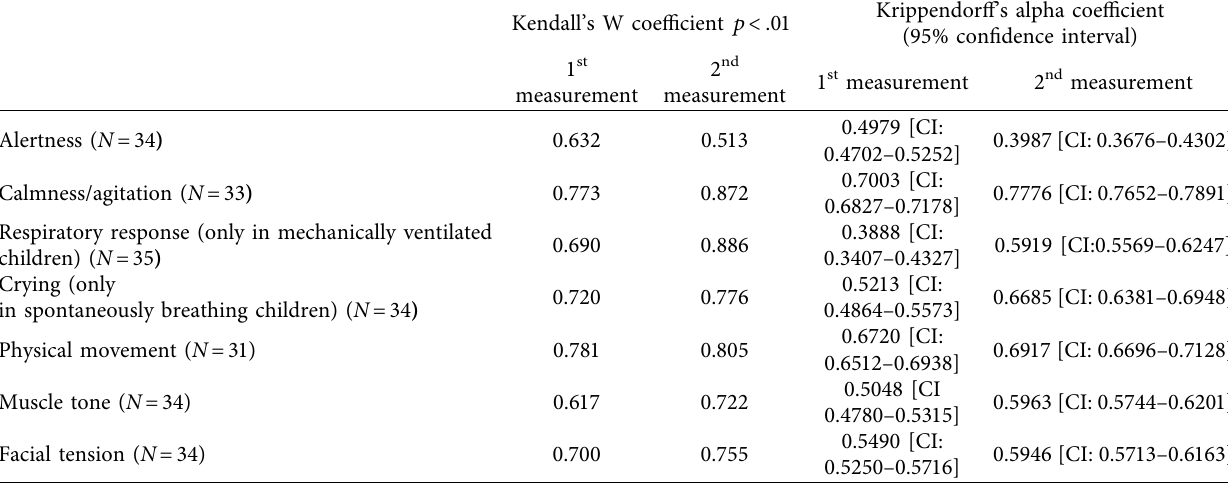
Table 6: COMFORT-B scale, interrater agreement item